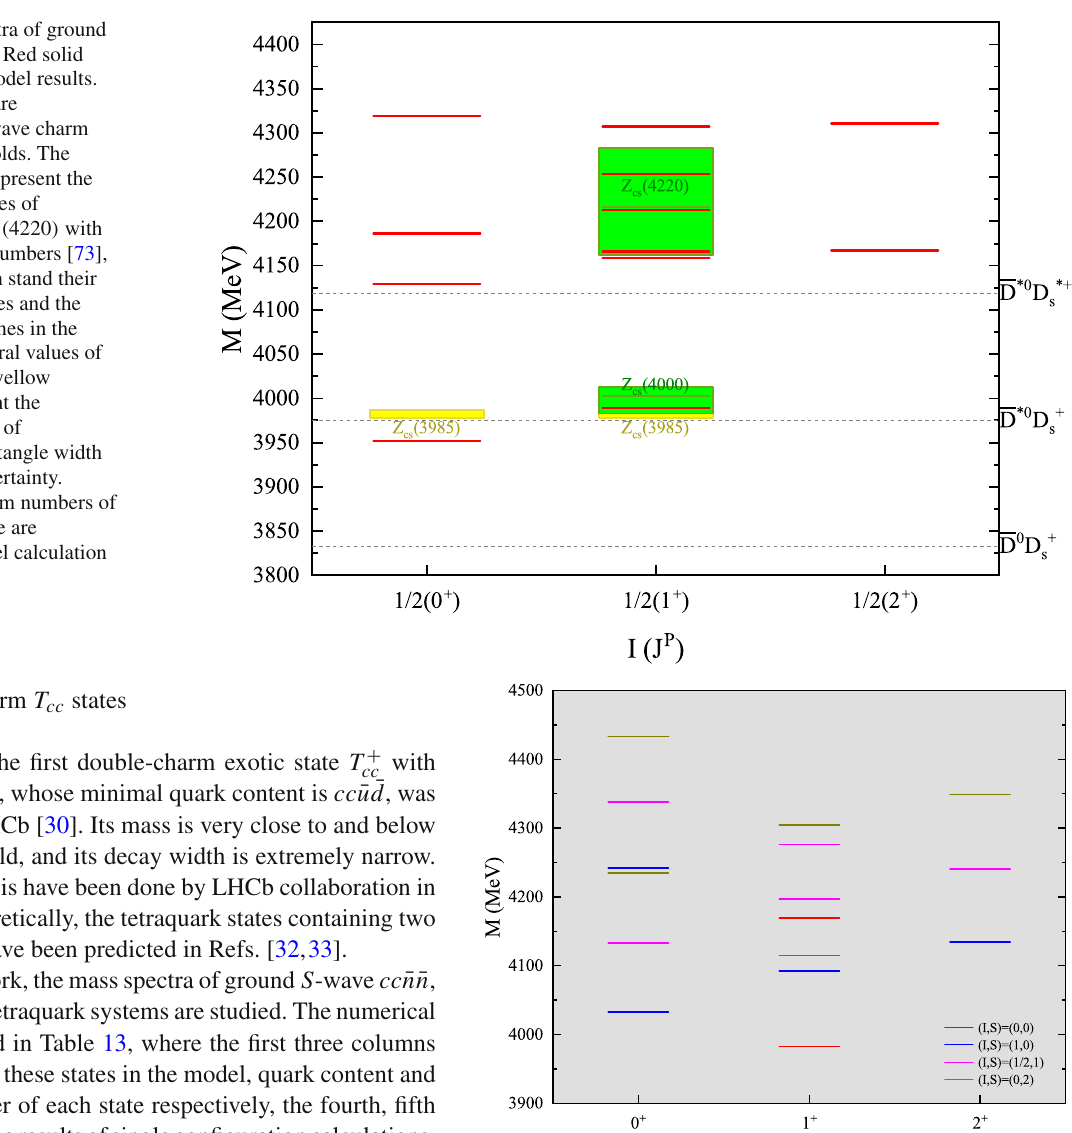
/ 2 , 1 cc states, green solid line